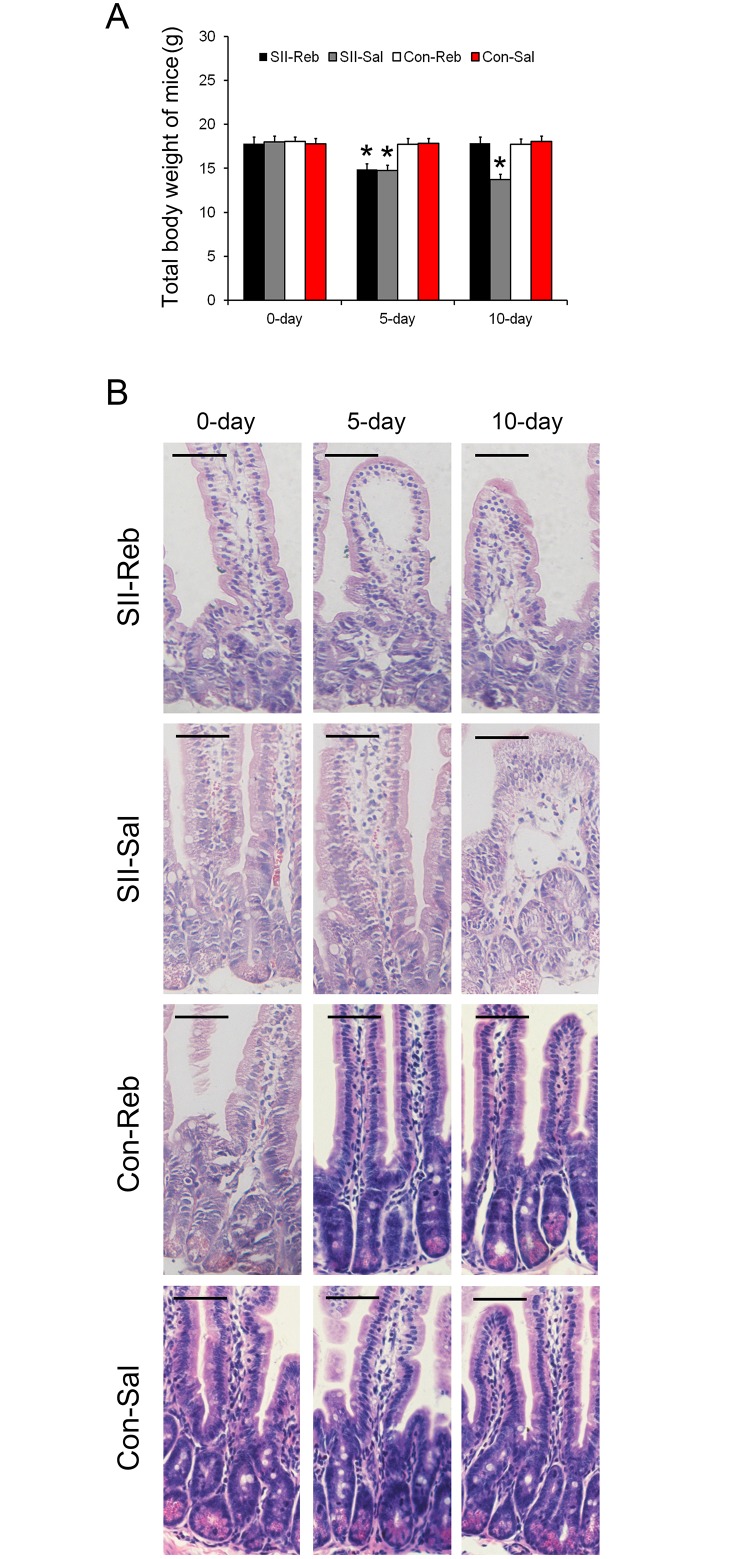
Body weights and histological changes of small intestines in mice.(A) The body weights of mice in the four groups were shown. The bars indicated the body weights of mice measured by gram (n = 6, *P < 0.05 when compared with Con-Reb and Con-Sal groups). (B) Histological changes of mice in the four groups were shown. In the SII-Reb and SII-Sal groups, the small intestine showed acute transmural injuries with villi atrophy, inflammatory cell infiltration, cell swelling, epithelial cell necrosis, and dilation of sub-epithelial space at day 5. The small-intestine enteritis of the SII-Reb mice after rebamipide administration was milder than that of the SII-Sal mice at day 10 (Bar indicates 50 μm).